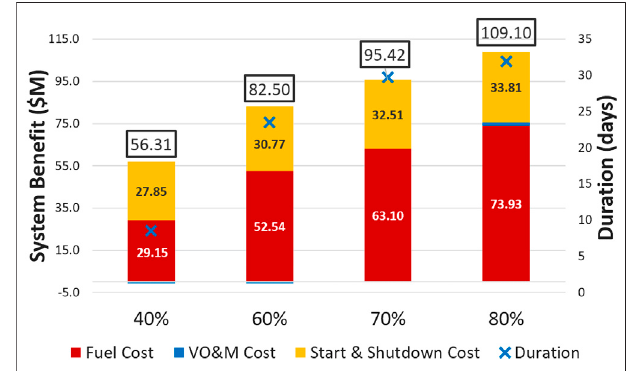
FIGURE 13 | Annual system bene fi ts including fuel, VO&M, and startup and shutdown cost reduction associated with the maximum bene fi t long- duration energy storage including energy storages with (A) 40% round-trip ef fi ciency and 9-day duration, (B) 60% round-trip ef fi ciency and 24-day duration, (C) 70% round-trip ef fi ciency and 30-day duration, and (D) 80% round-trip ef fi ciency and 32-day